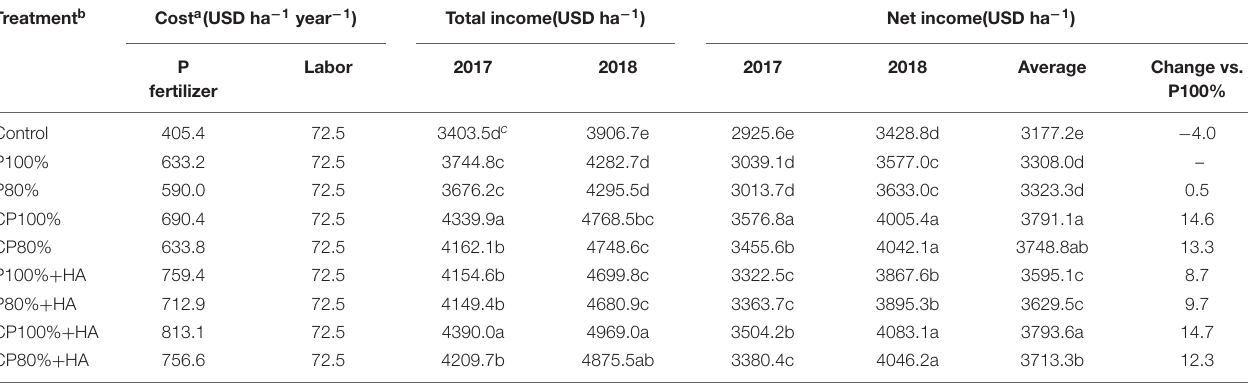
TABLE 3 | Cost and net profits of maize production in different fertilization treatments. Treatment